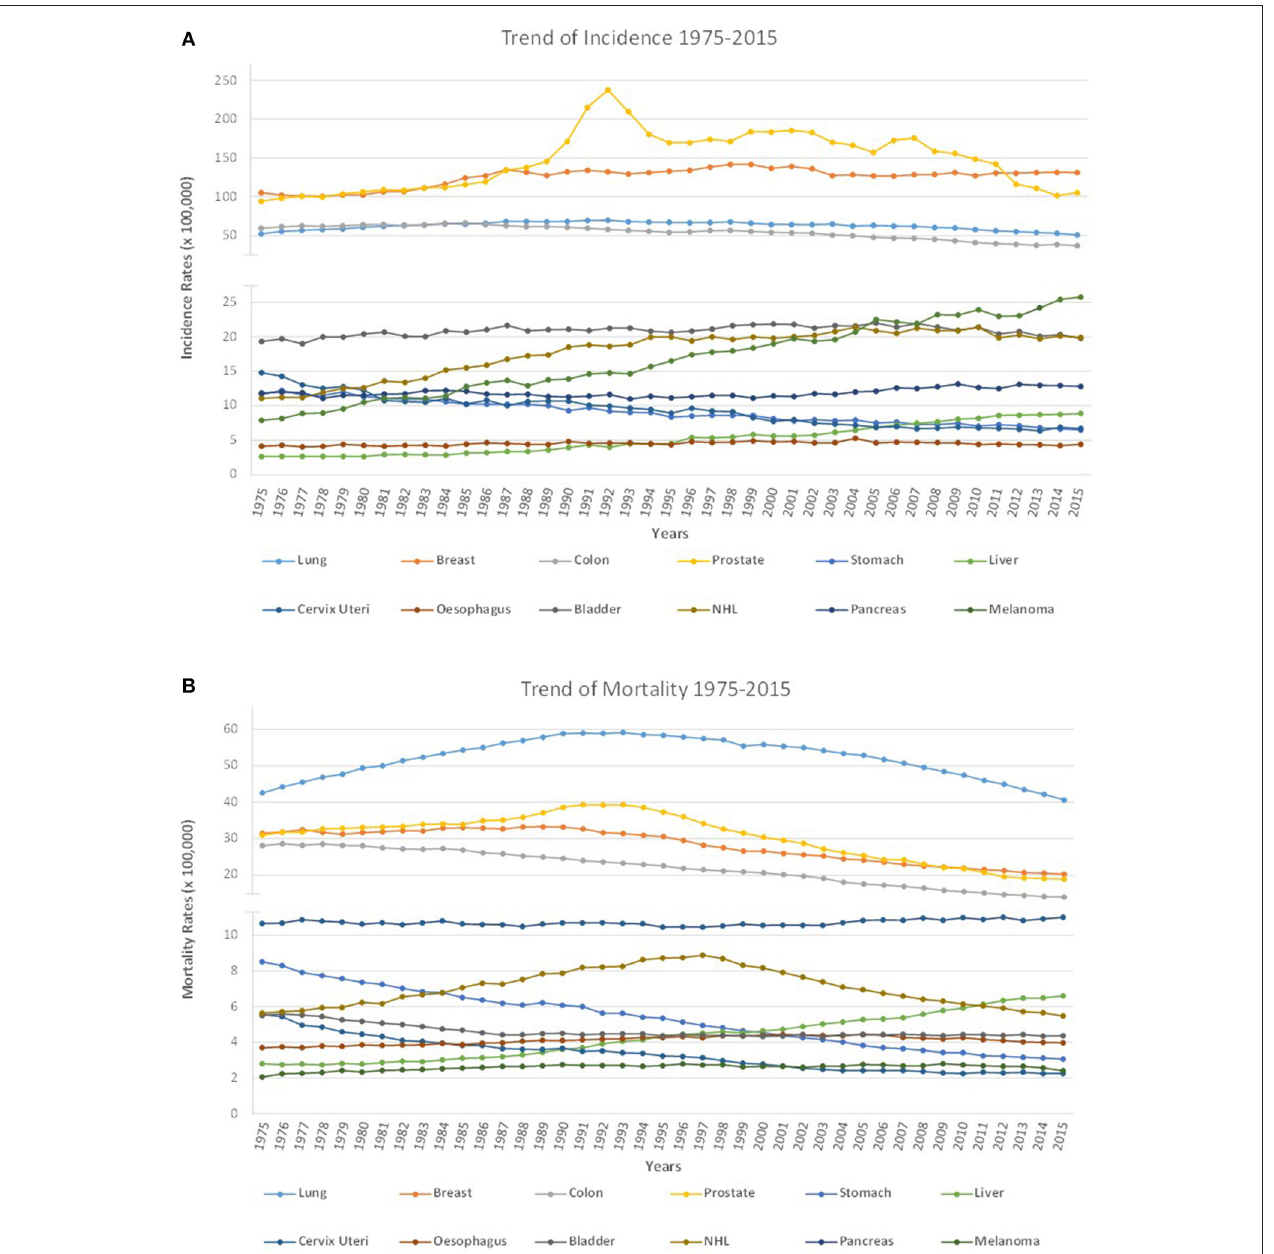
FIGURE 1 | Cancer incidence and mortality from 1975 to 2015. (A) In the last 40 years, from 1975 to 2015, there has been a general increase in incidence rates for several cancers as a consequence of the demographic increase. Thanks to cancer prevention and screening strategies the number of many types of cancer has decreased. In particular, for cervix uteri and stomach cancers, a decrease in incidence rates was observed, while the incidence rates for esophagus, bladder, lung and colon remained unchanged. Finally, an increase in incidence rates was recorded for hepatic carcinoma, for breast cancer, NHL and above all for melanoma, whose incidence has increased radically in recent years; (B) Cancer mortality rates have globally decreased thanks to the development of targeted therapy and immunotherapy. In particular, in the last 40 years there has been a decrease in mortality rates for prostate, breast, colon, bladder, and especially for cervix uteri and stomach cancers. Almost unaltered mortality rates are observed for melanoma, pancreatic and esophageal cancers for which really effective pharmacological treatments are not yet available. An increase in mortality was observed for hepatic carcinoma while lung cancer and NHL showed a variable trend over the years with a slight increase in mortality rates from 1975 to 1995, and a general decrease in mortality rates recorded above all in the last 20